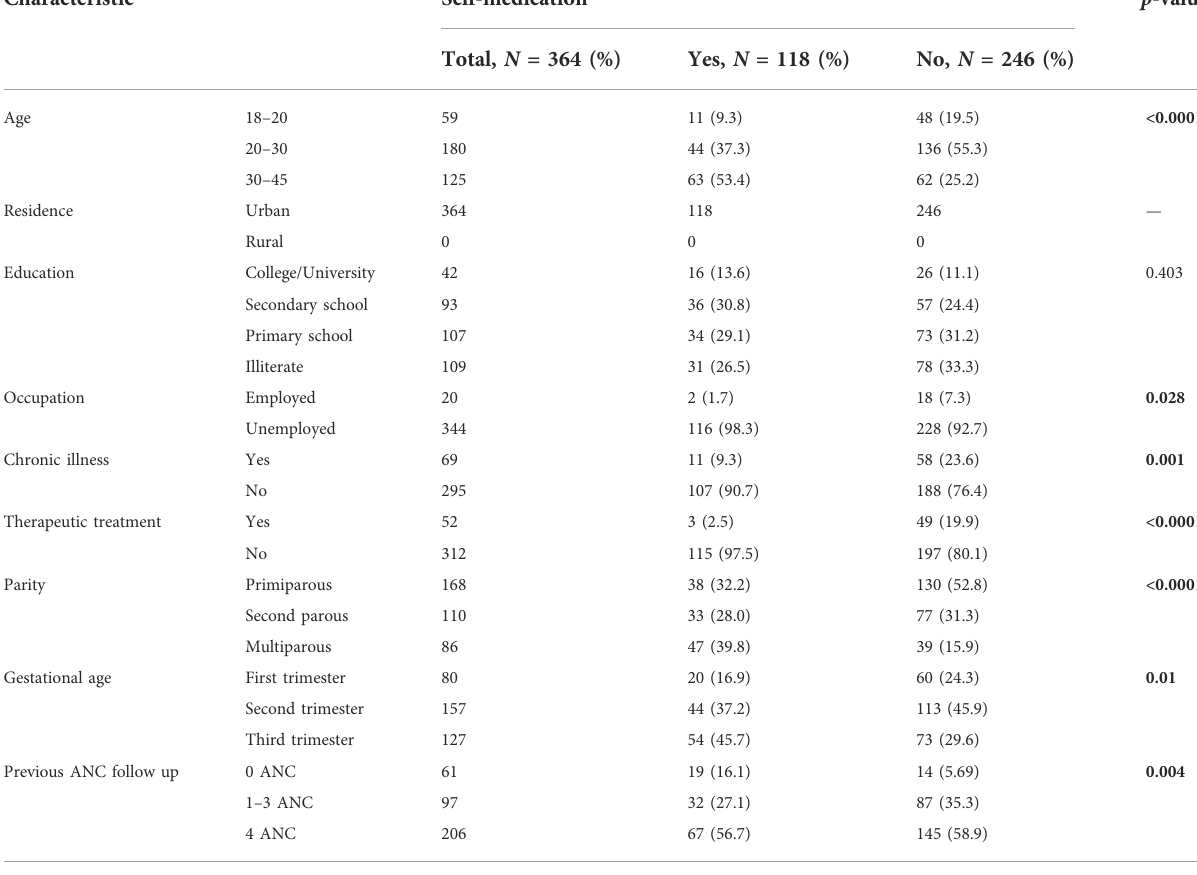
TABLE 1 Socio-demographic and obstetrical characteristics and self-medication during pregnancy of 364 women, 2019. Characteristic